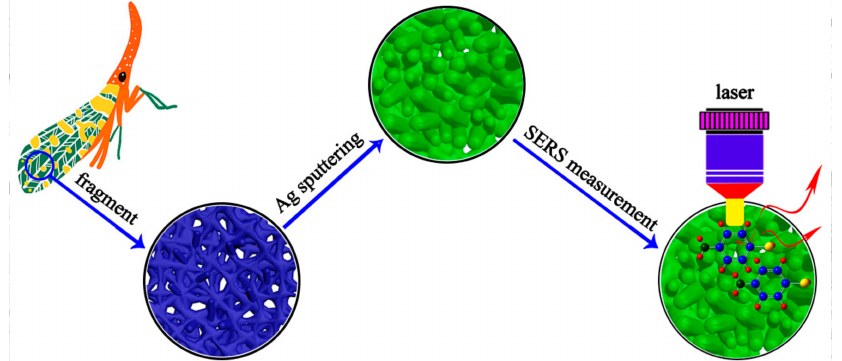
Figure 1. Schematic illustration of the fabrication program of the practical Ag/FCW substrates and SERS